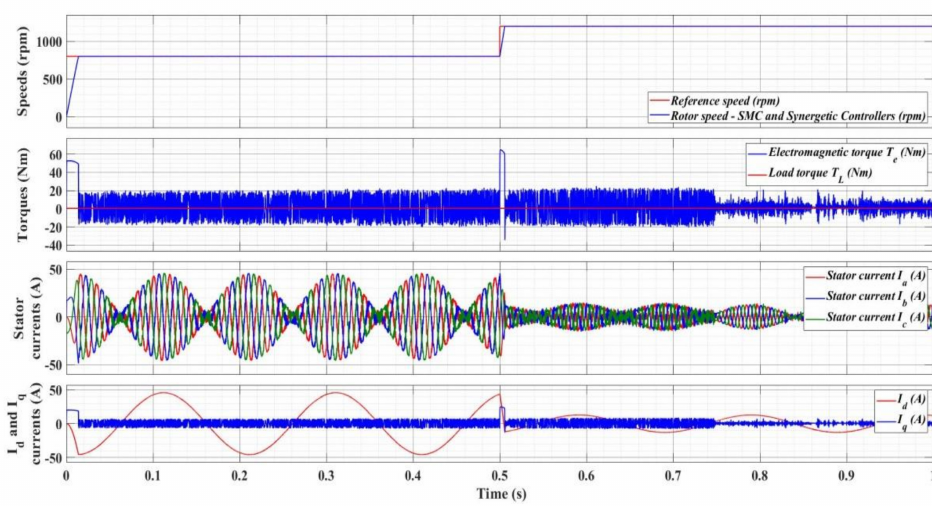
Figure 32. Time evolution for the numerical simulation of the PMSM control system based on control using SMC and synergetic